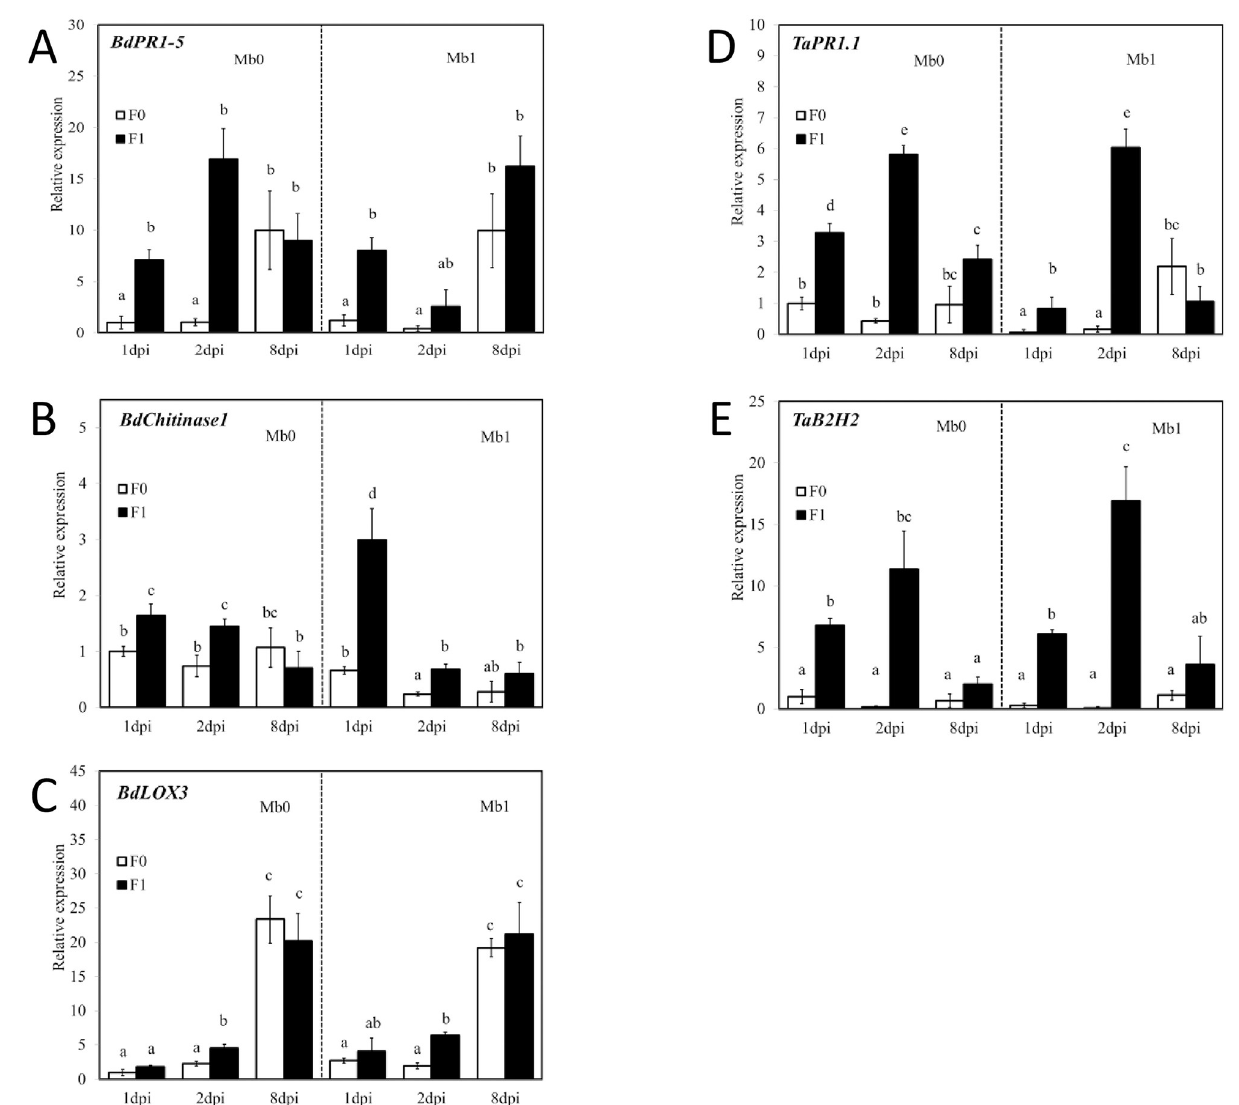
Fig 2. Expression profiles of genes BdPR1-5 (A), BdChitinase1 (B) and BdLOX3 (C) in Brachypodium distachyon (Bd) and TaPR1 . 1 (D) and TaB2H2 (E) in wheat inoculated with Microdochium bolleyi (Mb1) or not so inoculated (Mb0) and with leaves infected with Fusarium culmorum (F1) or not so infected (F0) at three time periods 1, 2, and 8 days post inoculation (dpi). Expression levels are relative to M . bolleyi non-inoculated and Fc non-infected leaves of plants at 1 dpi and were normalized with the reference genes BdSamDC and TaGADPH . Expression levels shown are mean values and standard deviations (whiskers) for three replications. Statistically significant differences are indicated by letters above columns (post hoc Tukey’s test, P < 0.05).